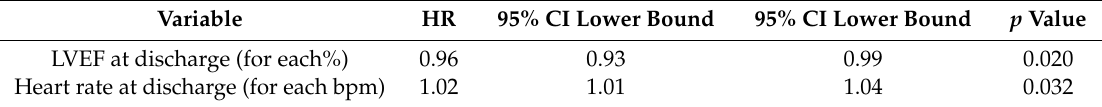
Table 4. Multivariable Cox-proportional hazard model for cardiovascular hospitalization.